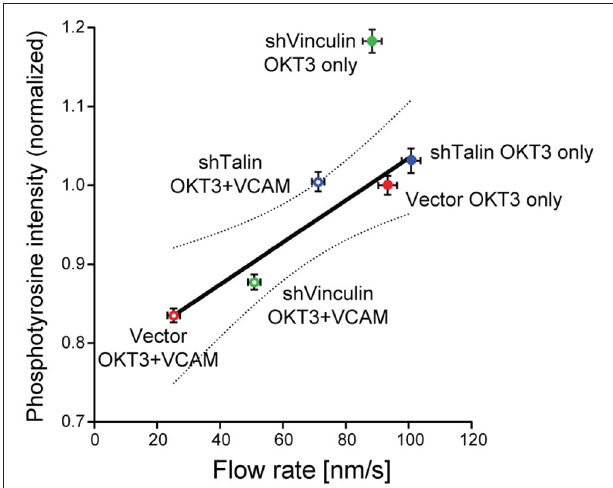
FIGURE 2 | Correlation between actin flow rates and tyrosine phosphorylation during T cell activation. Results from two types of experiments were combined to assess how actin flow rates affect TCR signaling. Jurkat T cells stably expressing GFP-actin were transduced with recombinant lentiviruses expressing shRNAs specific for vinculin or talin, or with an empty control vector. Cells were selected with puromycin and suppression was verified by immunoblotting. Cells were then allowed to spead on glass coverslips coated with 10 µ g/ml anti-TCR (OKT3, BioXCell), alone or in combination with 2 µ g/ml VCAM-1 Fc (R&D Systems), and imaged by spinning disk confocal microscopy. Actin flow rates within the lamellipodial region were determined by kymographic analysis as detailed in (Jankowska and Burkhardt, 2017). In parallel studies, cells were allowed to spread on stimulatory coverslips for 5min, fixed, permeabilized, and labeled for phosphotyrosine (PY20, directly conjugated to Alexafluor-488 using the Mix-n-Stain kit from Biotium). Cells were imaged by confocal microscopy (50–60 randomly selected cells per condition, z-stacks of 3-planes spaced 0.25 µ m apart), and the integrated signal intensity from the rendered stacks was measured using Volocity 6.3 by manually drawing a ROI around each cell. Average phosphotyrosine signal per cell was then plotted as a function of actin flow rates. In vector-transduced control cells, VCAM-1 engagement slows the actin flow rate and decreases phosphotyrosine signaling. Knocking down the clutch molecules talin or vinculin relieved the slowing effect of integrin engagement, suggesting that mechanical drag is at least partly responsible for the slowing of the actin network. Regression analysis revealed a linear correlation between actin flow rates and phosphotyrosine signaling, with R 2 = 0.90. Dotted line shows the 95% confidence interval. Data represent means ± SEM from three independent experiments. Note that shVinculin on OKT3 falls outside this confidence interval, suggesting an additional function of vinculin beyond a clutch in this system. These data show that the actin network serves as a mechanical intermediate through which integrins modulate TCR signaling. Adapted from Jankowska et al.